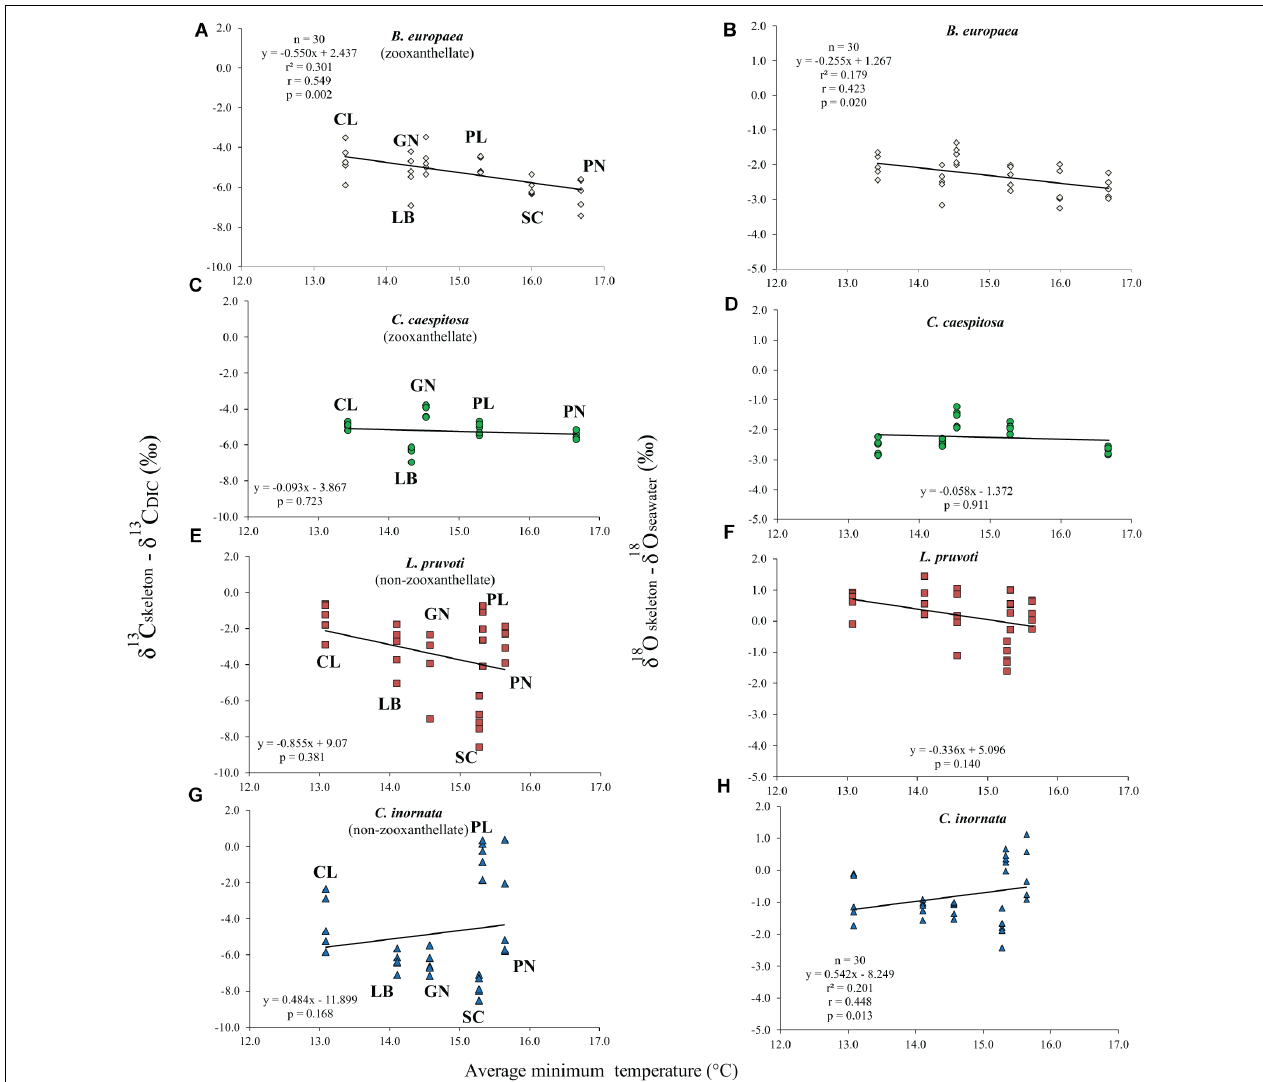
FIGURE 5 | The relation between skeletal δ 13 C and δ 18 O with average minimum temperature in B. europaea (temperature at 6 m; A,B ), C. caespitosa (temperature at 6 m; C,D ), L. pruvoti (temperature at 16 m; E,F ), and C. inornata (temperature at 16 m; G,H ). r 2 , Spearman’s determination coefficient; r , Spearman’s correlation coefficient; n , number of